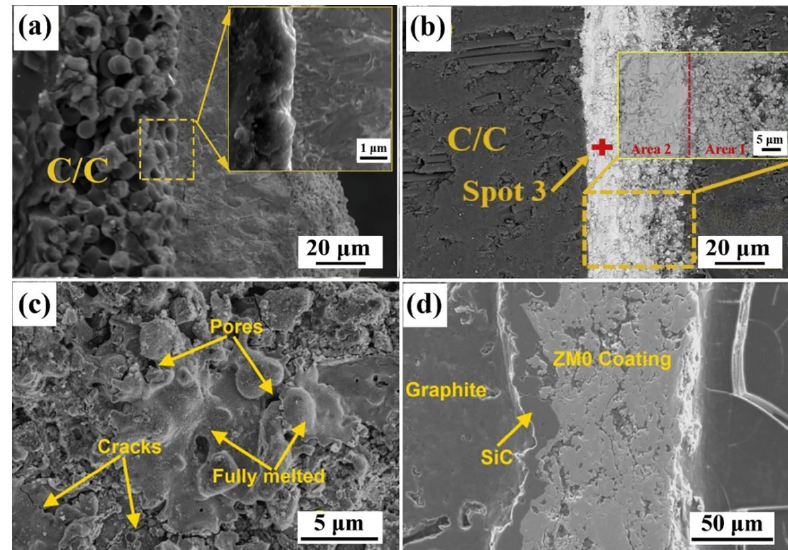
Fig. 31 Typical morphologies of the single UHTC coatings: cross-section of the CVD–HfC coating before ablation (a); cross-section of the CVD–HfC coating after ablation (b). Reproduced with permission from Ref. [309] , © Elsevier Ltd. 2020. Surface and cross-section of PS–ZrC coating (c, d). Reproduced with permission from Ref. [312], © Elsevier Ltd and Techna Group S.r.l.